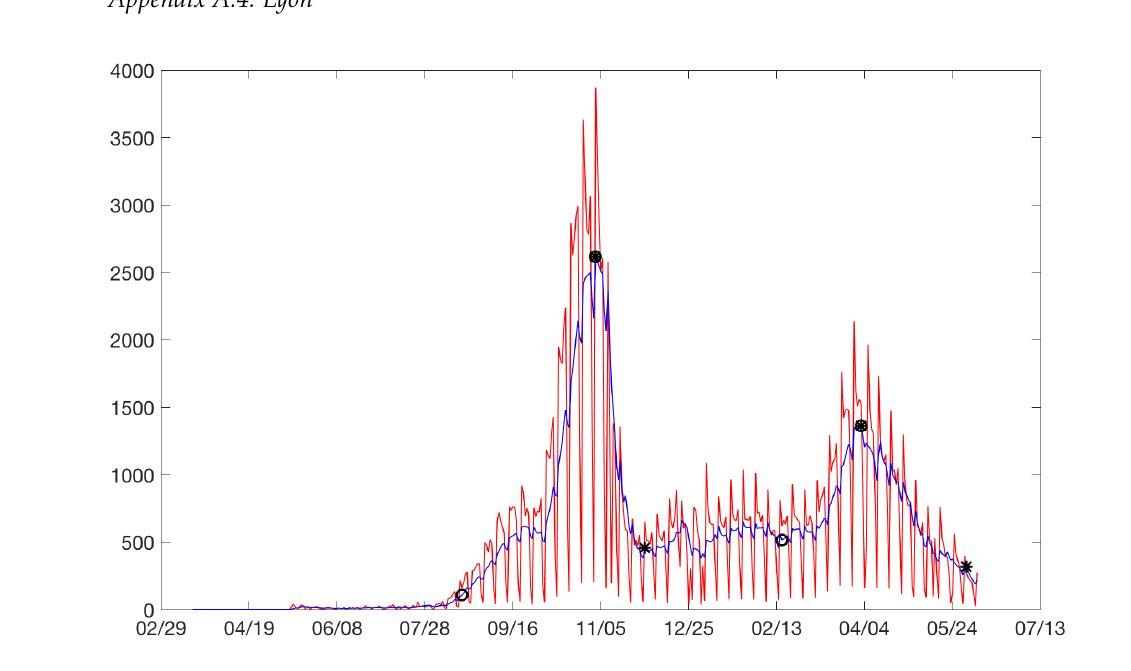
Figure A9. Lyon: on the horizontal axis is the date in days and on the vertical axis are the daily cases.